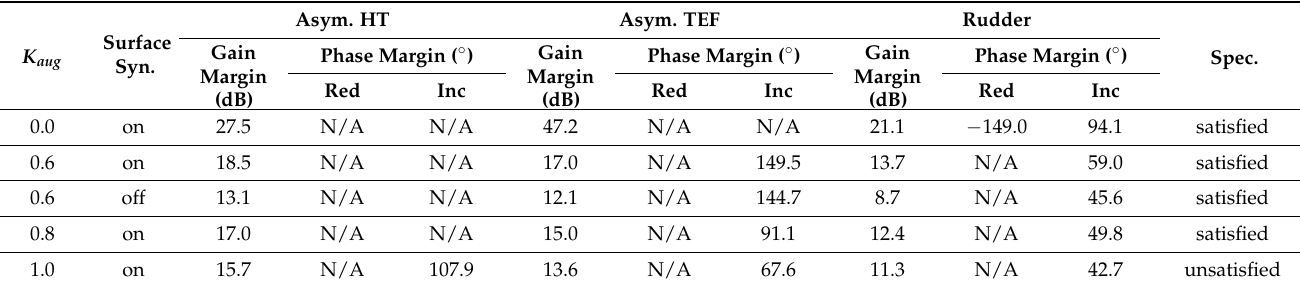
Table 3. Result of stability margin analysis as a variation of additional augmentation gain and control surface synchroniza- tion in Mach 0.8, altitude 20 K, 1 g level flight. Surface K aug